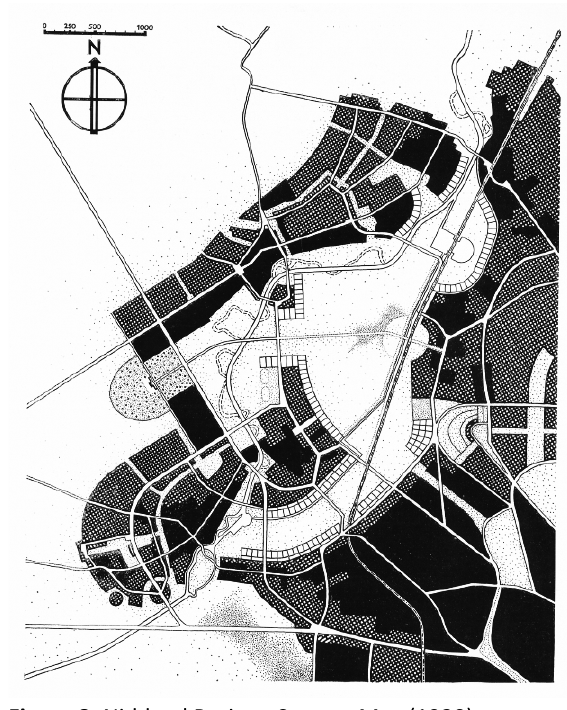
Figure 8. Niddatal Project. Source: May (1930).